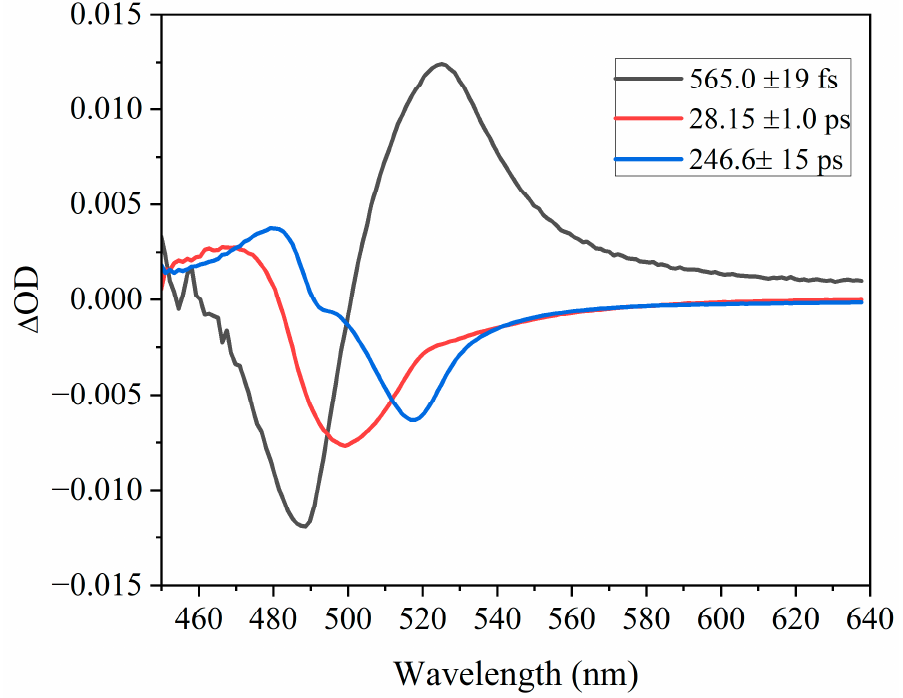
Figure 4. Decay correlation spectra of CsPbBr 3 .